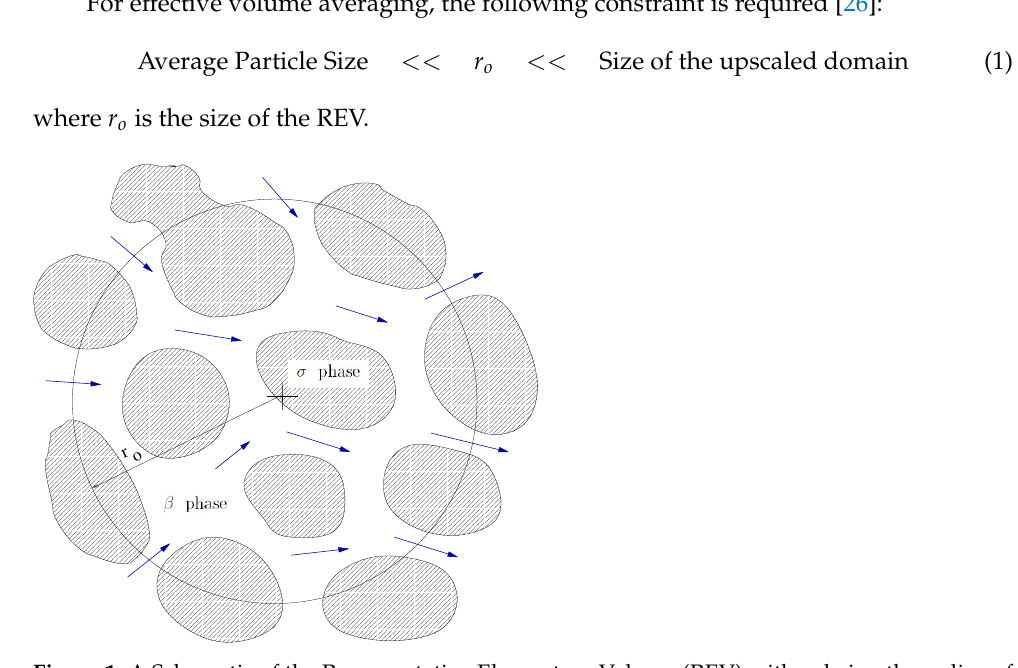
Figure 1. A Schematic of the Representative Elementary Volume (REV) with r o being the radius of the sphere-shaped